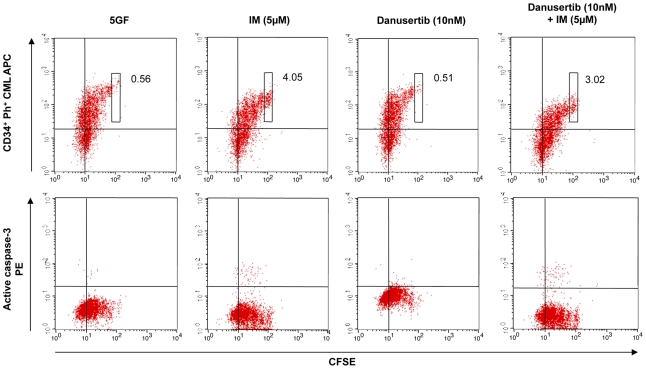
Cell division tracking using CFSE assay.Assessment of CD34 expression or active caspase-3 expression versus CFSE fluorescence remaining in cells following 72 hours of in vitro treatment with 5GF alone, 5 µM IM, 10 nM Danusertib and 5 µM IM+10 nM Danusertib. The boxes shown indicate undivided cells (CD34+, CFSEmax) and the numbers represent the percent of total viable cells in this gate.